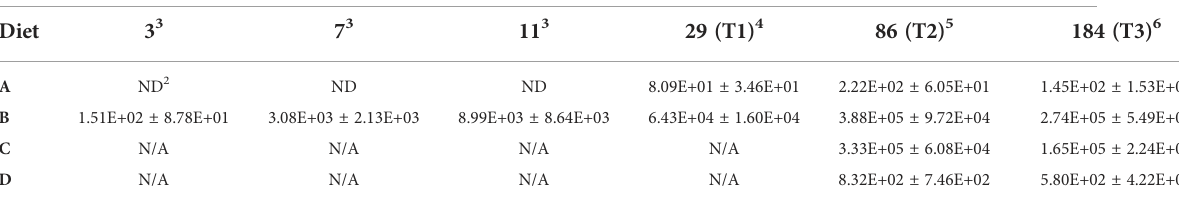
TABLE 3 Steelhead trout probiotic ingestion as detected by qPCR analysis 1 .